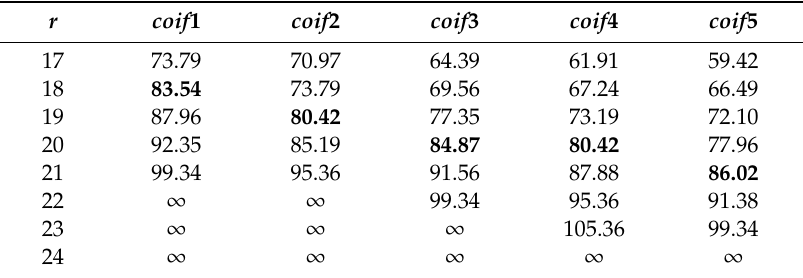
Table 9. Calculation results ( PSNR , dB) of 3D medical images (with 16 BPC) DWT by using bit-width r of coiflets filters coe ffi